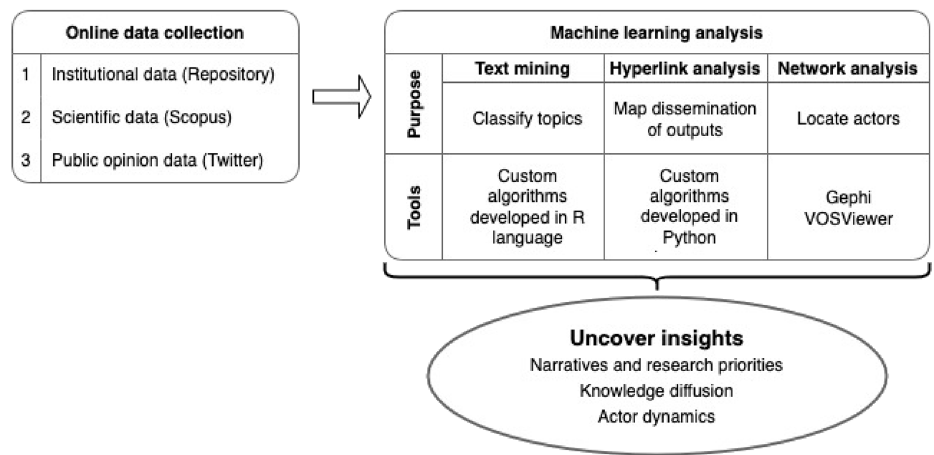
Figure 1. Analytical framework for digital research to assess knowledge flows of scientific